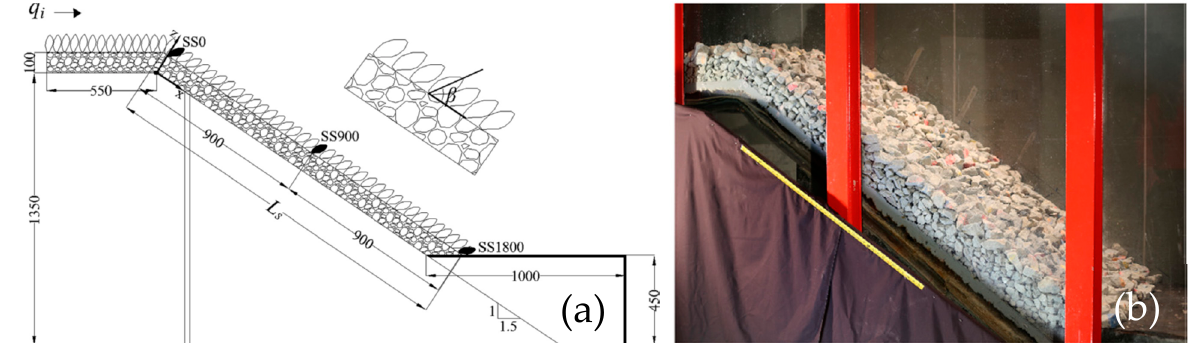
Figure 5. From Ravindra et al. [9], ( a ) depiction of experimental set-up of riprap model unsupported at the toe and ( b ) image of dumped riprap model with such setup.